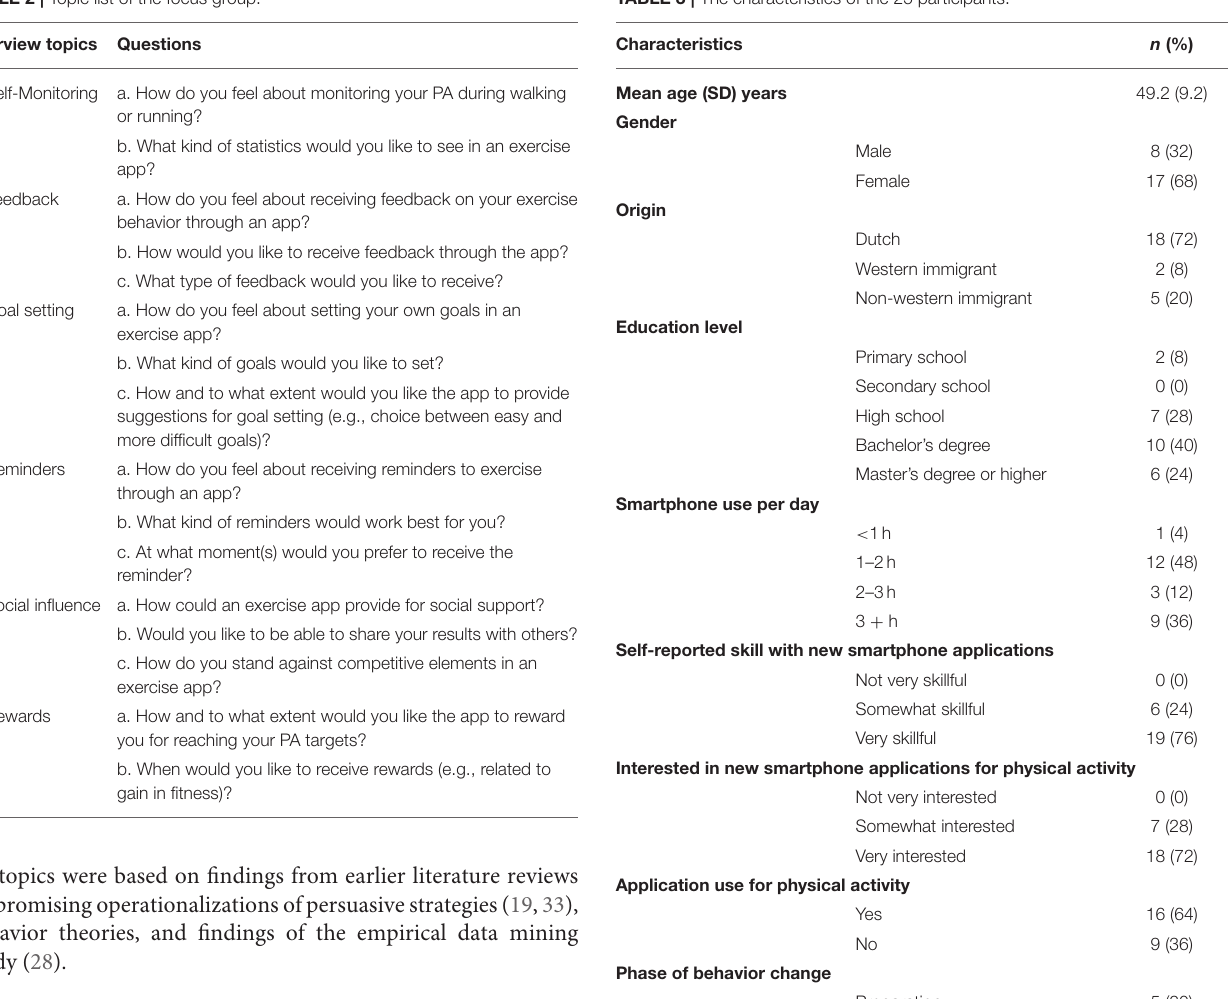
TABLE 2 | Topic list of the focus group. TABLE 3 | The characteristics of the 25